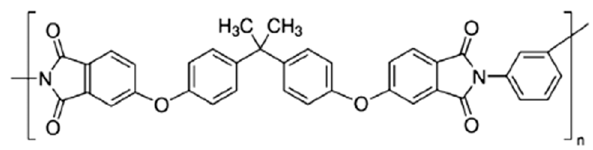
Figure 1. Formula of Ultem ® polyetherimide.